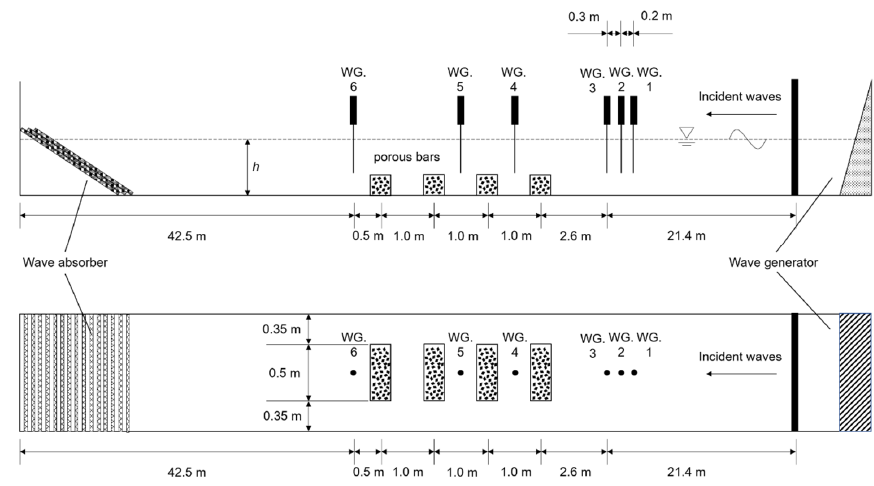
Figure 2. Sketch of experimental setup in side view and plan view.